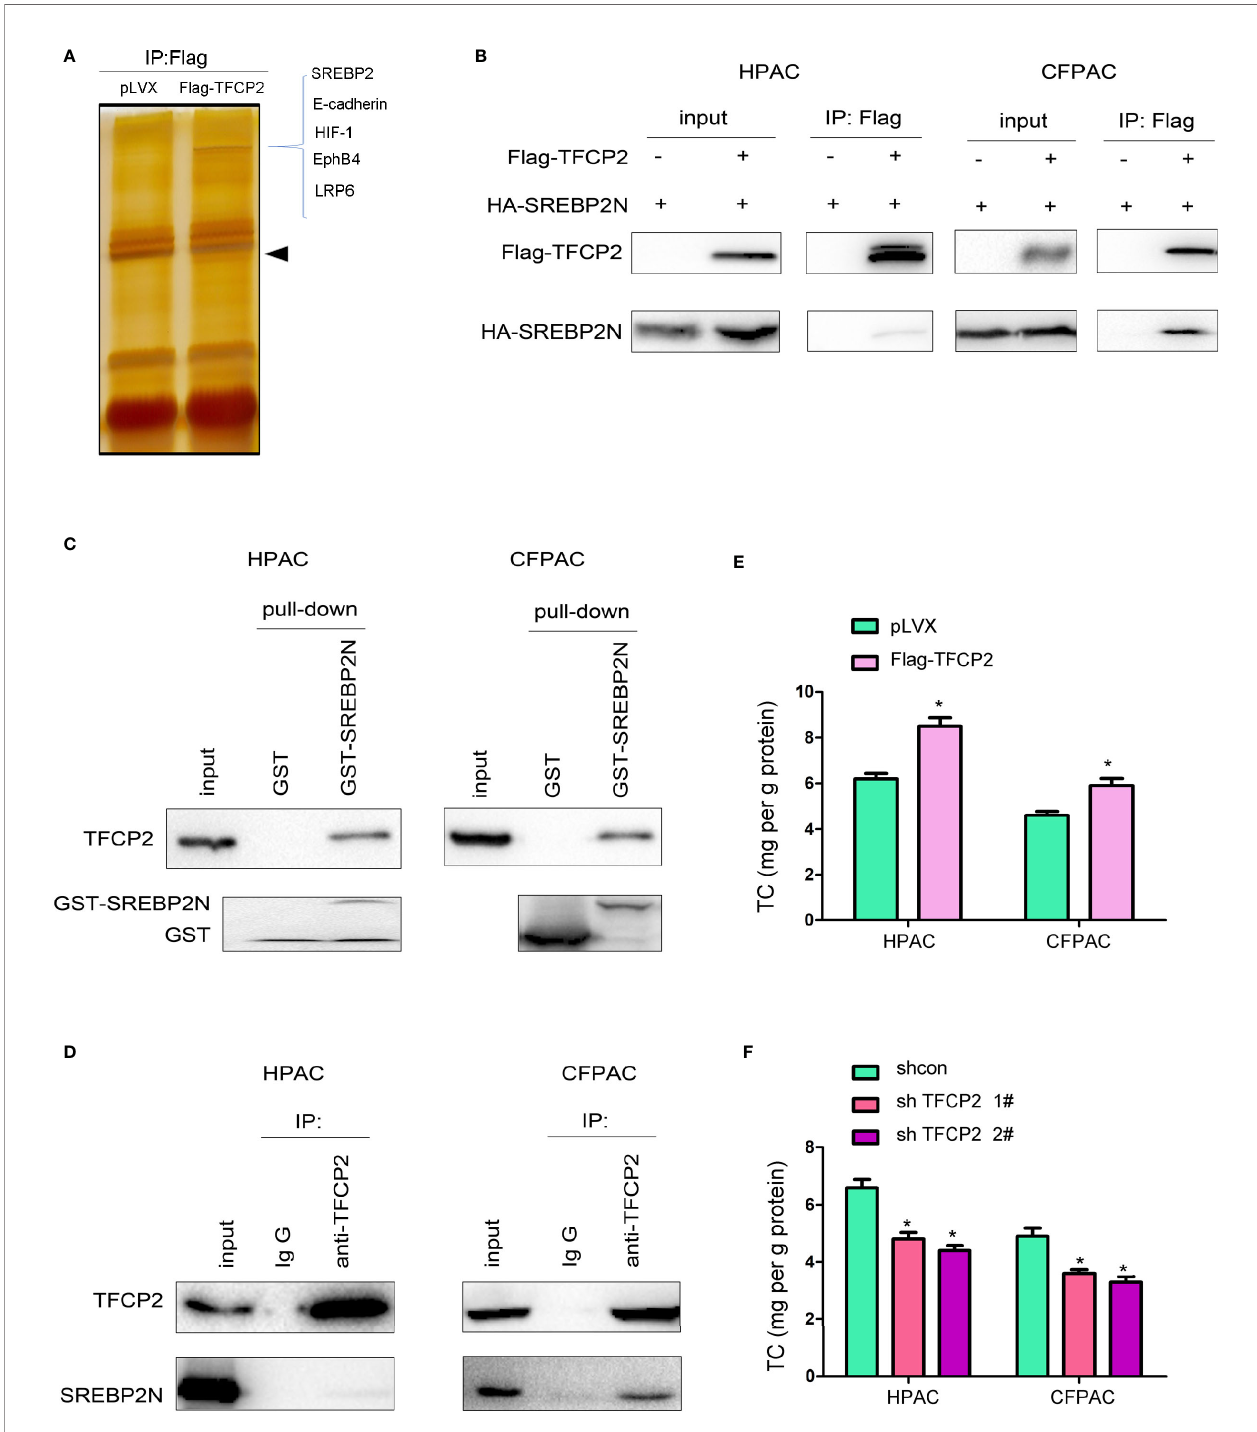
FIGURE 5 | TFCP2 interacted with SREBP2. (A) The silver staining. HEK293T cells were transfected with the vector expressing TFCP2 (Flag-TFCP2). 48 hours later, cells were lysed and the immunoprecipitation was performed using anti-Flag antibody. The immunoprecipitates were separated with SDS-PAGE, and the gel was stained with silver. The differential band was cut for mass spectrum identi fi cation. Arrow head, the band for Flag-TFCP2. (B) Immunoprecipitation was performed 48 hours after cells were transfected with Flag-TFCP2 and HA-SREBP2(N) plasmids. (C) GST pull-down assay was performed after the cell lysate was incubated with the GST-SREBP2(N) fusion protein overnight. (D) Immunoprecipitation was performed to examine the interaction between endogenous TFCP2 and SREBP2(N). (E, F) The content of cholesterol in the cells with TFCP2 overexpression (E) or knockdown (F) . * P <